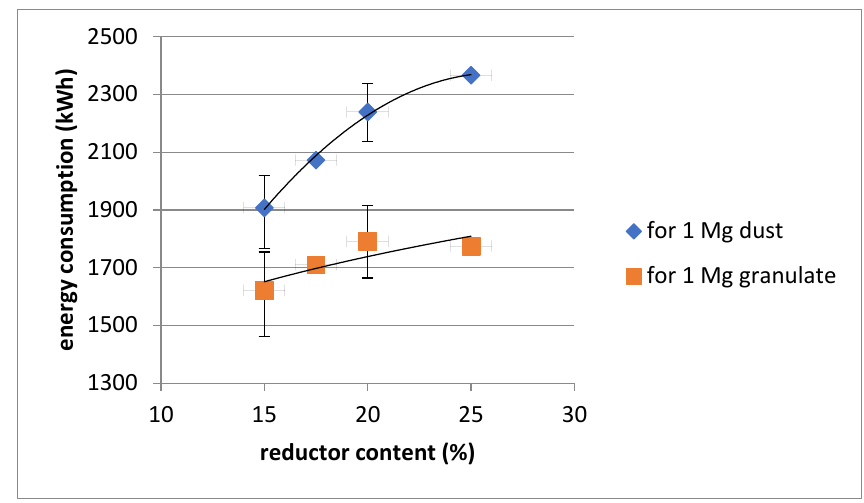
Figure 3. Energy consumption for smelting 1 Mg of dust and 1 Mg of granulate.